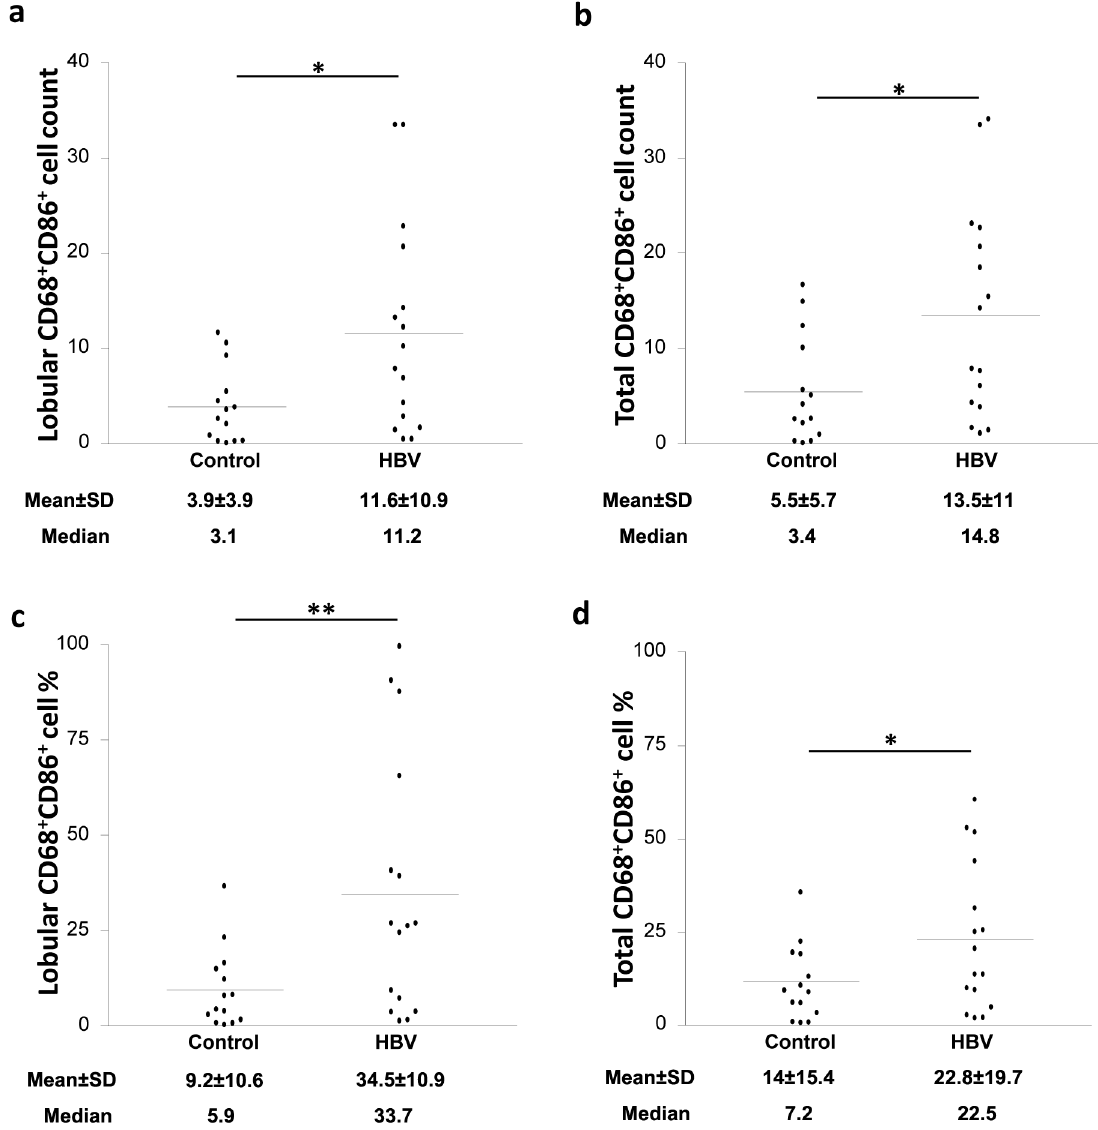
CD86 Abs. CD68 + CD86 + cell count in ( A ) the lobular area and ( B ) the total (lobular and portal) areas of the liver of control and HBV-infected individuals. CD68 + CD86 + cell percentage in ( C ) the lobular areas and ( D ) the total (lobular and portal) areas of the liver of control and HBV-infected individuals. * P value < 0.05. ** P value <